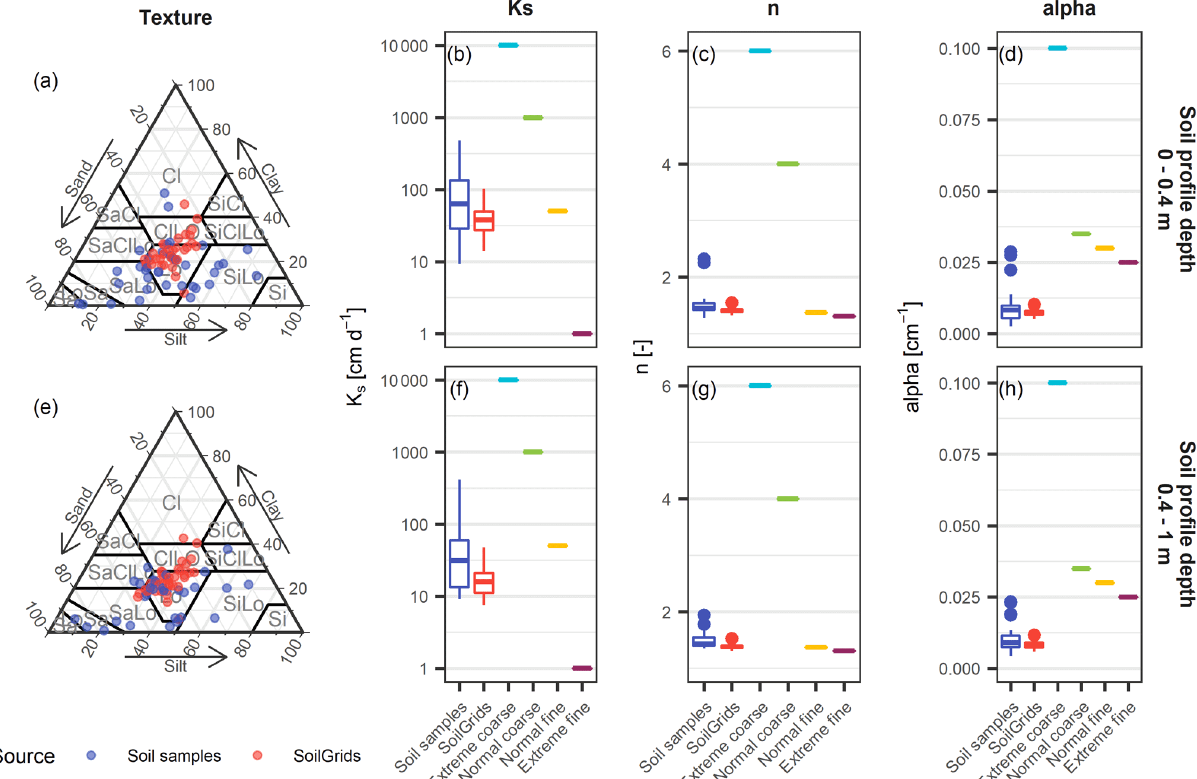
Figure 2. Soil texture splits (a, e) and soil hydraulic properties K s (saturated hydraulic conductivity), n (Van Genuchten coefficient) and α (Van Genuchten coefficient) (b–d, f–h) of the 35 monitoring sites averaged for the model layers in 0–40cm (a–d) and 40–100cm depth (e–h) . The point and box plot colours indicate different sources of information (soil samples, SoilGrids and uniform texture